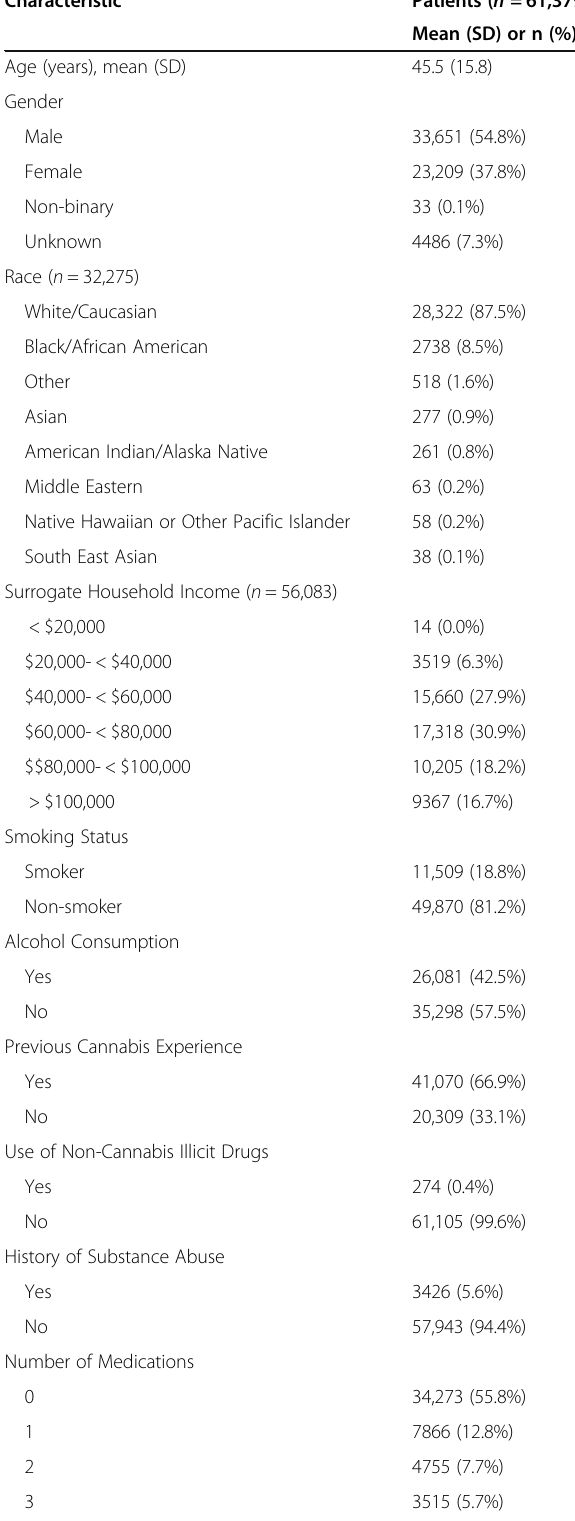
Table 1 Sociodemographic and medical characteristics